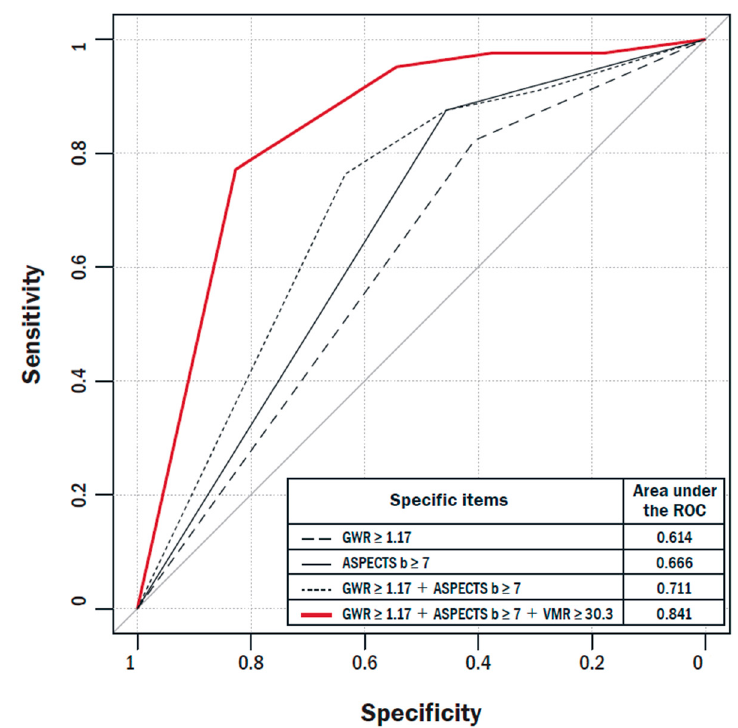
Figure 3. Receiver operating characteristic curve compared by adding vasomotor reactivity parameters to the traditional imaging study. ASPECTS-b, bilateral Alberta stroke program early computed tomography score; GWR, gray-to-white matter ratio; VMR, vasomotor reactivity.